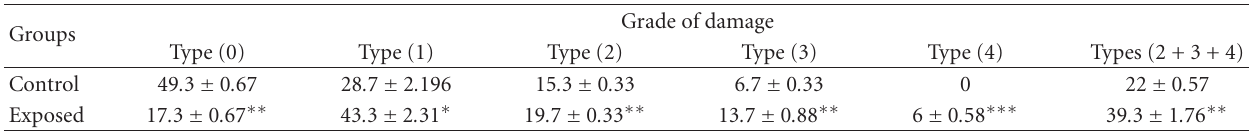
Figure 2: Brain of control group (a and b). (a) The neuroepithelium (bold arrow) is of normal cellularity and architecture, with the supportive astroglial tissue (thin arrow) at × 100 (H and E). (b) The astro-glial tissue is of normal cellularity, showing pyramidal astro- glial cells, with indistinct cell boundaries, having fibrillary cytoplasmic processes (arrows) at × 400 (H and E). Brain of exposed group (c and d). (c) The field shows marked astro-glial hypercellularity (i.e., reactive gliosis) at × 200 (H and E). (d) The astro-glial tissue shows marked hypercellularity (i.e., secondary reactive gliosis), with a di ff used vascular congestion (arrows) accompanied by extravasation of RBCs, as well as partial obliteration of lumen with thickened hypertrophied fibrous vessel wall (encircled) at × 300 (H and E). Table 2: DNA damage in the brain of newborn rats after whole body exposure to 50Hz and 0.5 mT MF for 30 days 24h/day, assessed by comet assay. Each value was expressed as mean of 10 rats ± standard